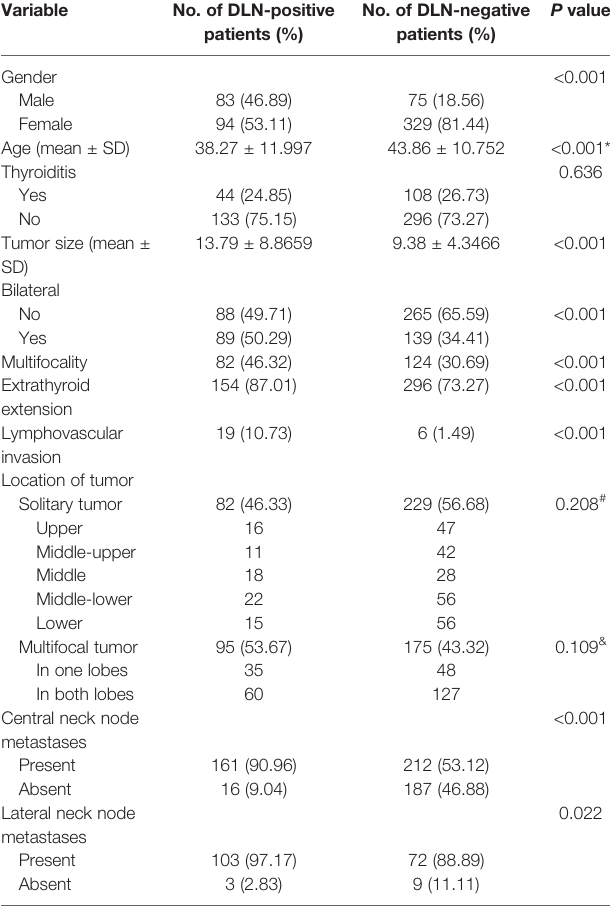
TABLE 2 | Comparison of clinicopathological characteristics between the patients with and without DLN metastasis.